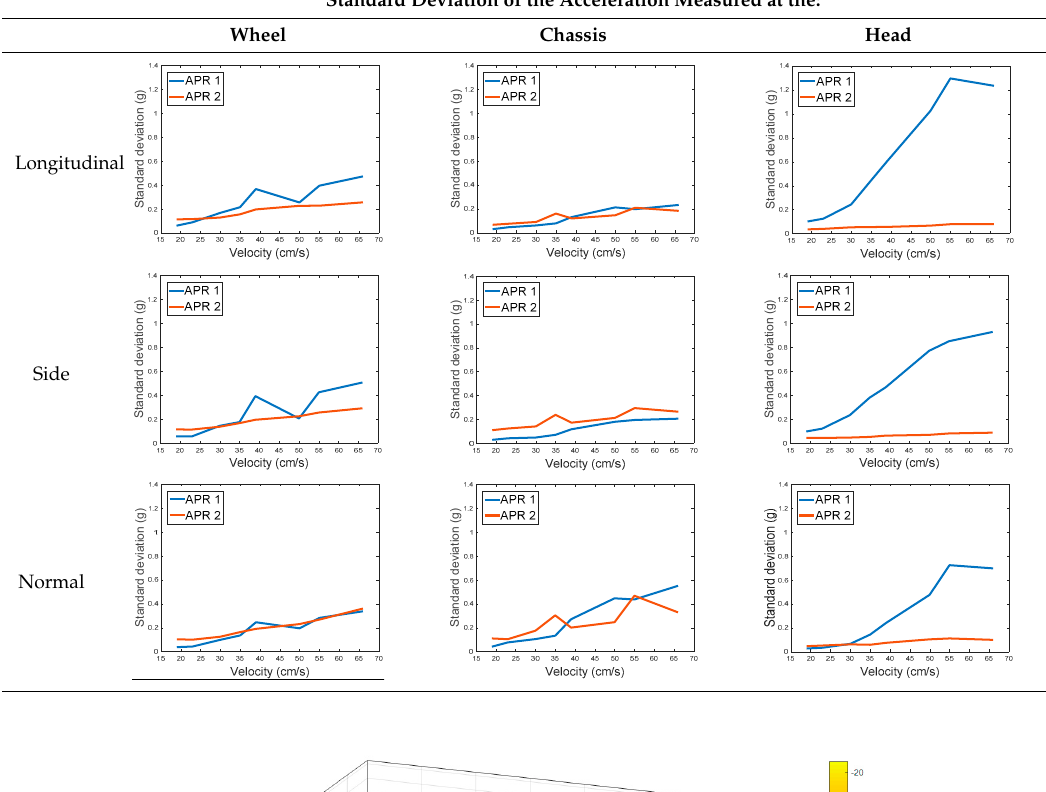
Table 9. Comparison of the vibrations’ standard deviation measured in the APR-1 and APR-2 prototypes.